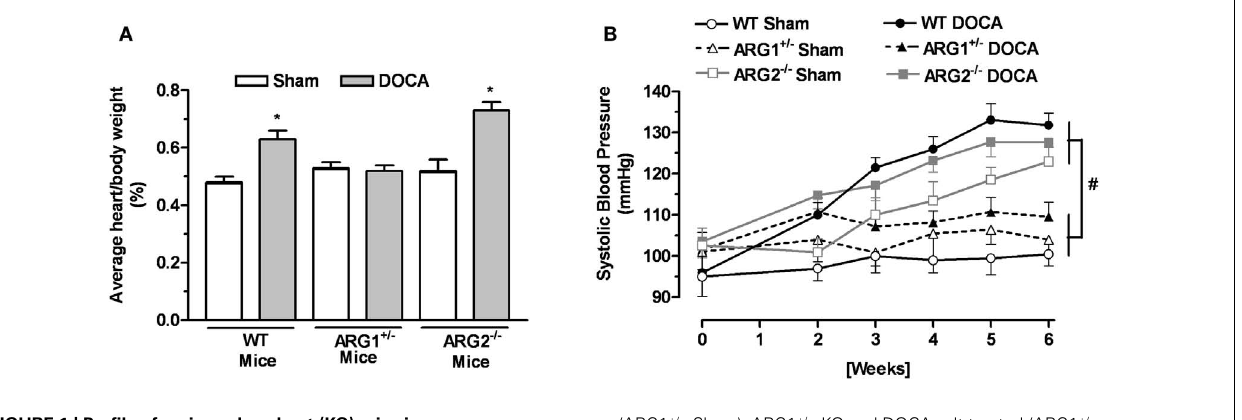
FIGURE 1 | Profile of arginase knockout (KO) mice in DOCA-salt treatment . Ratio between heart and body weight (A) and systolic blood pressure (SBP) (B) ofWT uninephrectomized (WT Sham),WT uninephrectomized and DOCA-salt treated (WT DOCA), partial arginase 1 (ARG1 + / − ) KO uninephrectomized